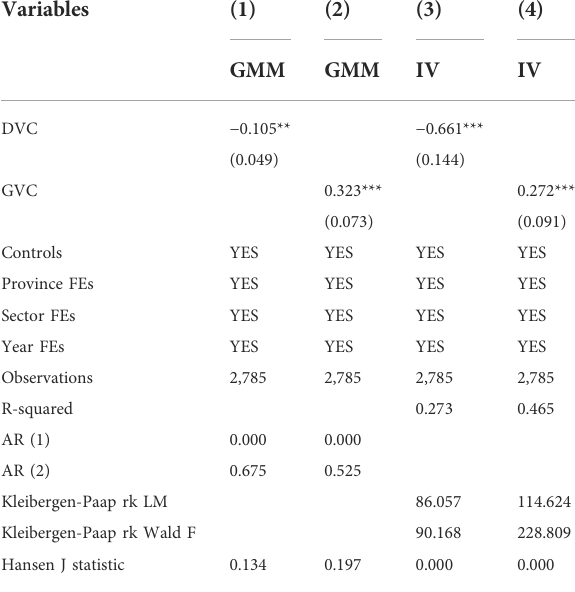
TABLE 5 Endogeneity regression